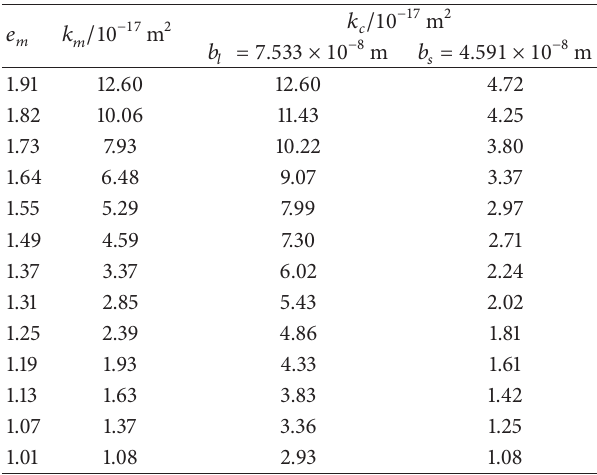
Figure 3: Comparison of the calculated and measured permeabili- ties of sea clay using the square